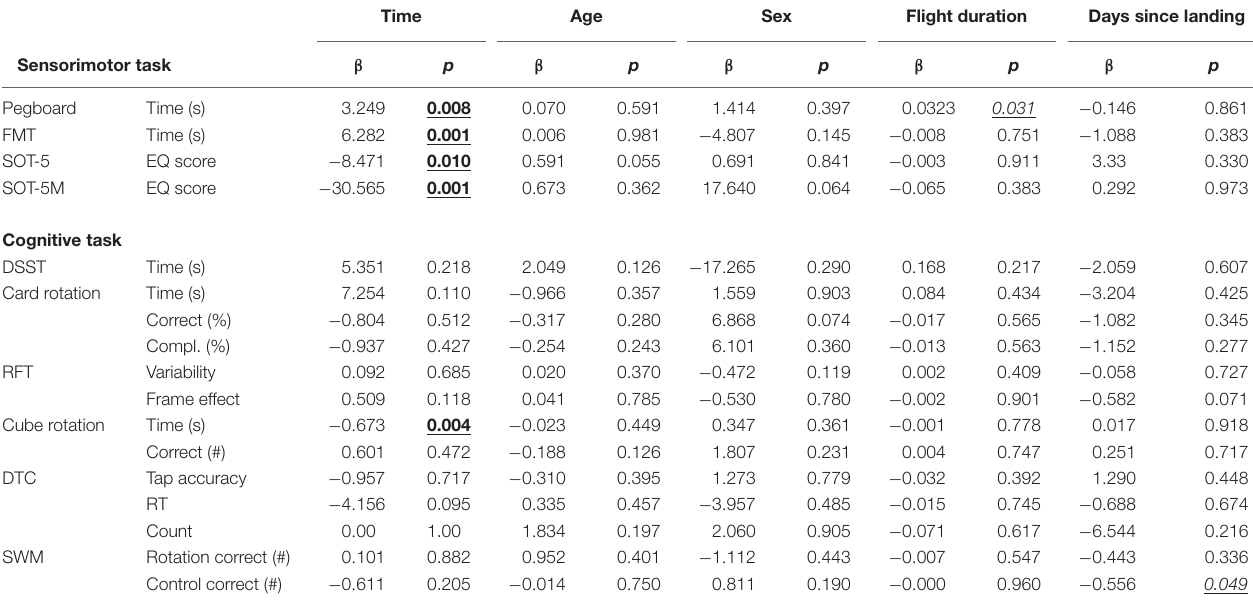
TABLE 3 | Effects of the microgravity environment.